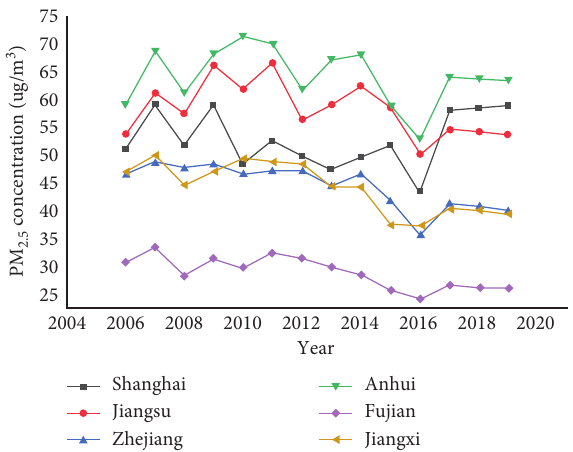
Figure 2: The Gini coefficients and prediction values of East China. Figure